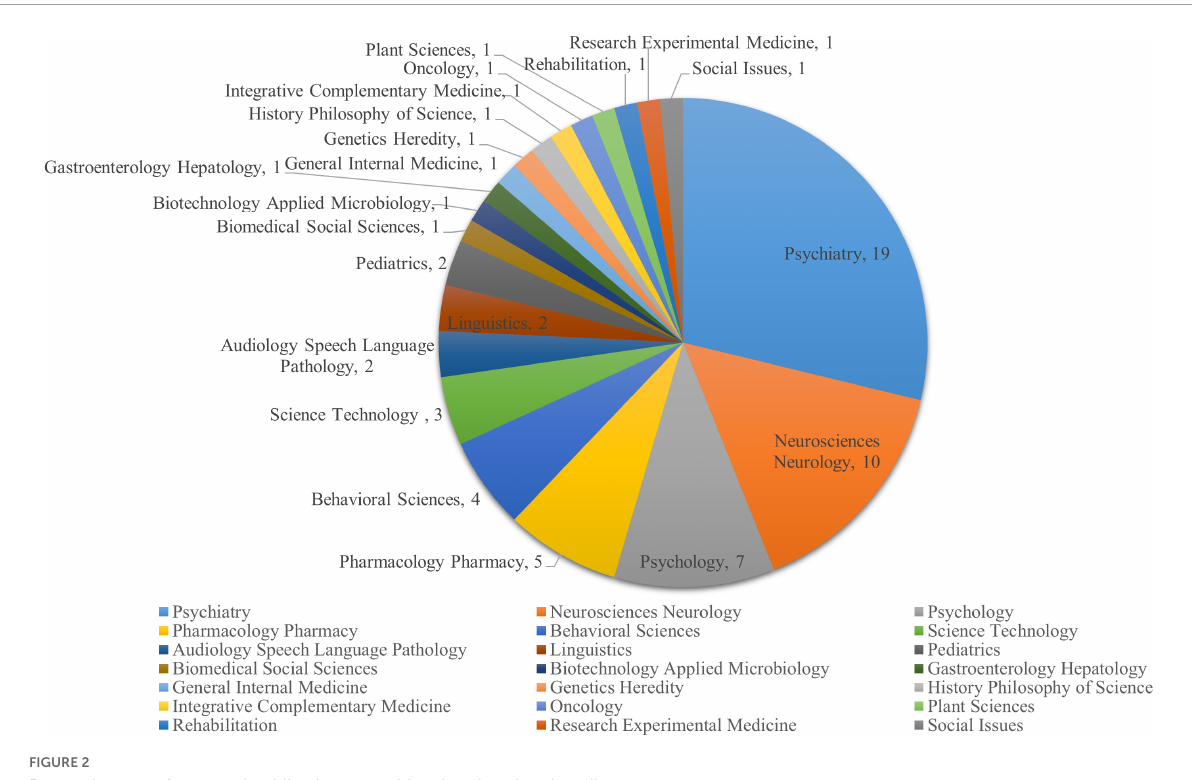
FIGURE2 Research areas of retracted publications on schizophrenia-related